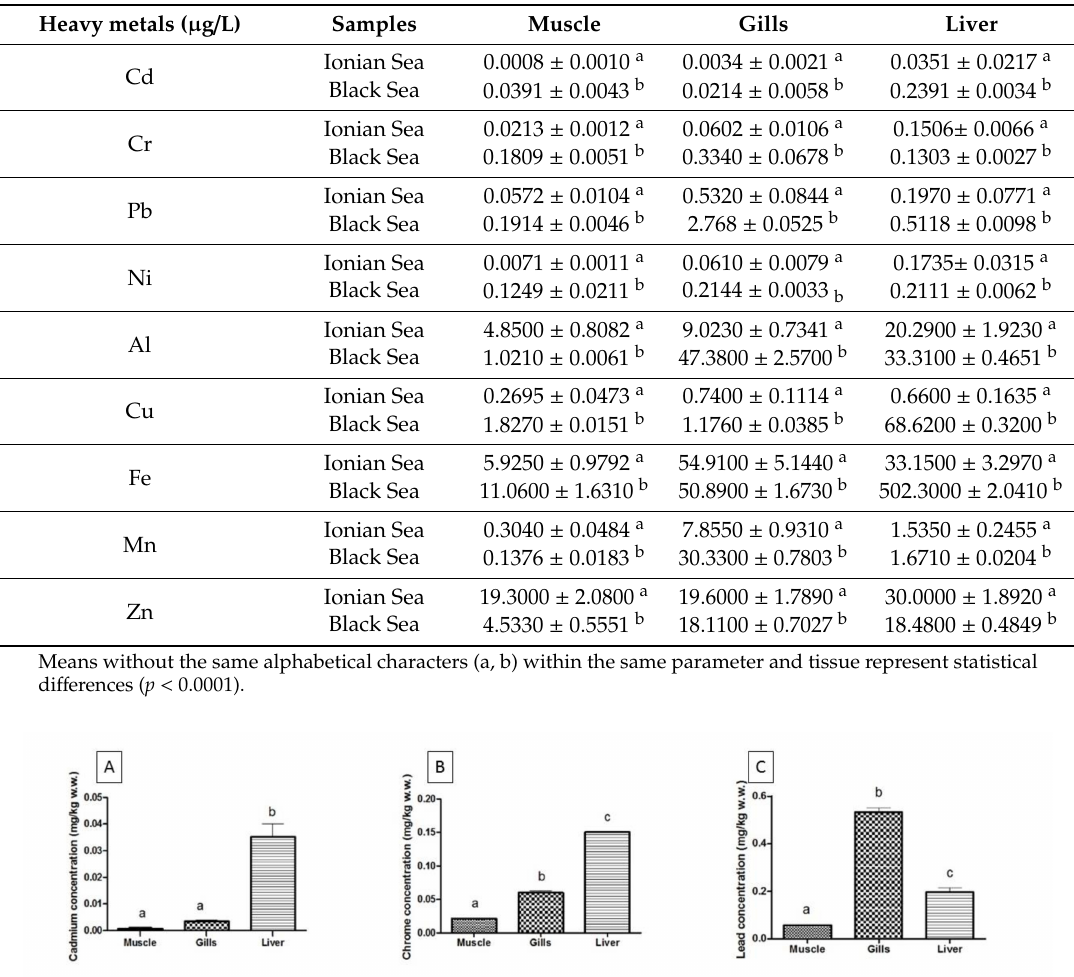
Table 3. Trace element concentrations (mean ± SD) of the various tissues measured in the grey mullet Mugil cephalus (Linnaeus, 1758) caught from the Ionian Sea (Italy) and the Black Sea (Bulgaria).